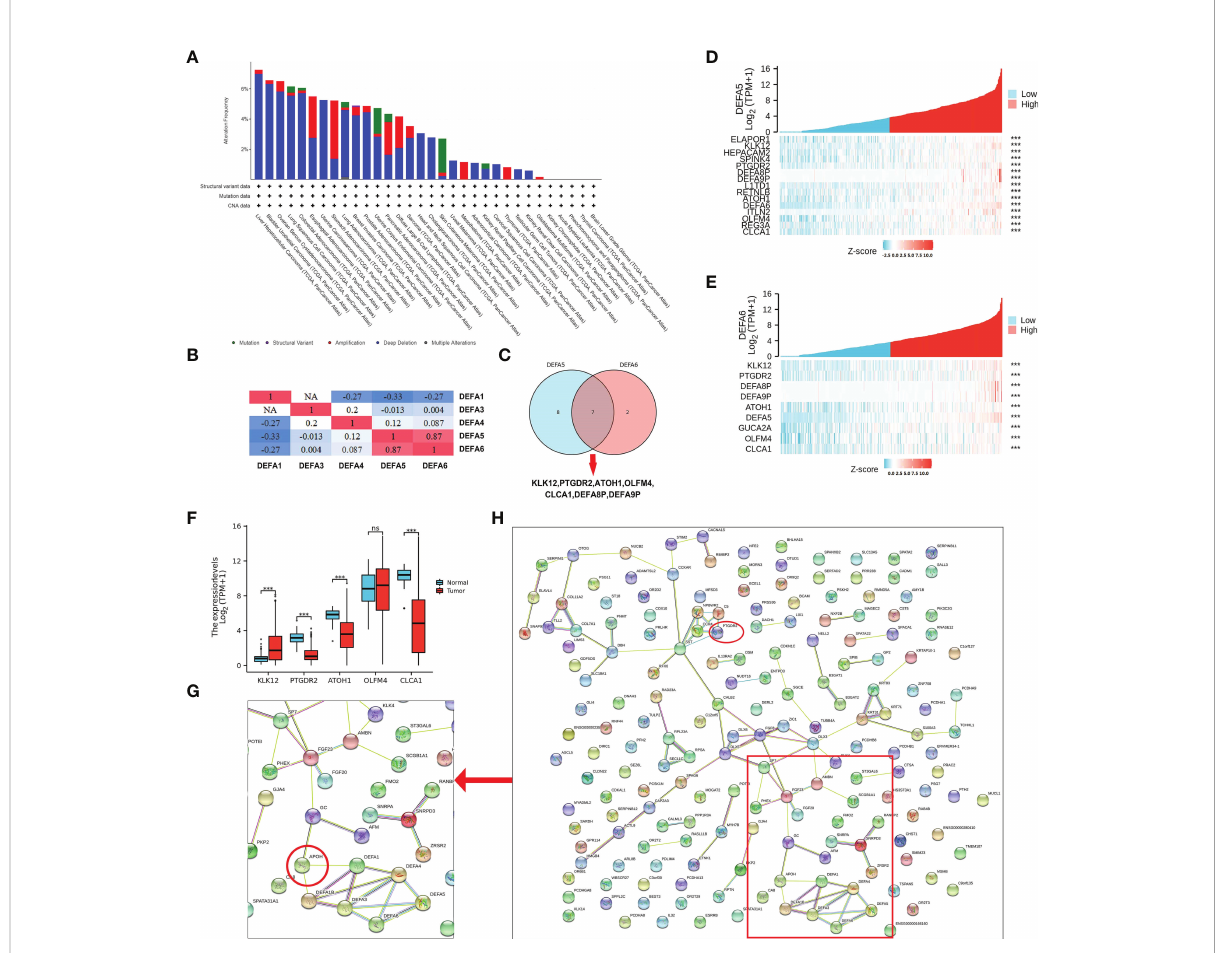
FIGURE 8 Mutation and co-expression genes of DEFAs in CRC. (A) Mutation rates of DEFA6 in pan-cancer; (B) Correlations among DEFAs; (C) Co- expressed gene Wayne diagram of DEFA5 and DEFA6; (D) Co-expression gene of DEFA5; (E) Different expression of Hub gene; (F) Co- expression gene of DEFA6; (G) Key proteins near DEFAs in protein protein interaction network (PPI network); (H) PPI network of related genes of DEFA5 and